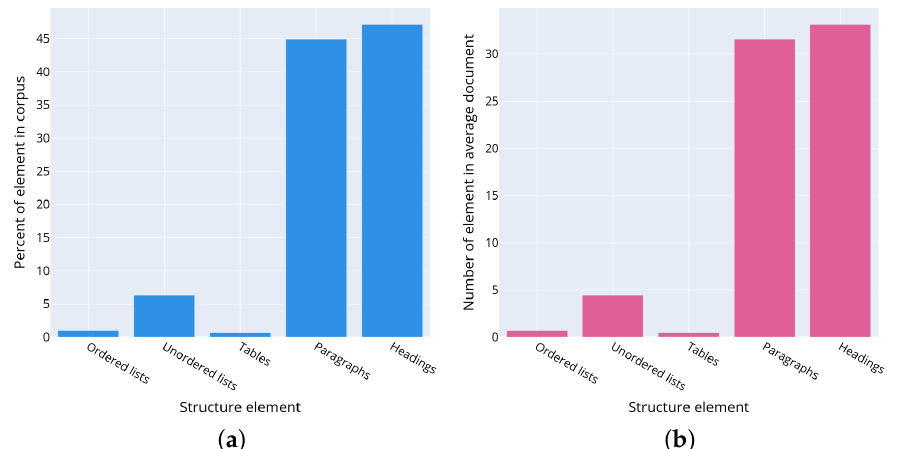
while the y -axis indicates the total number of structural elements in the text of each privacy policy. The color reflects the type of text structural element.